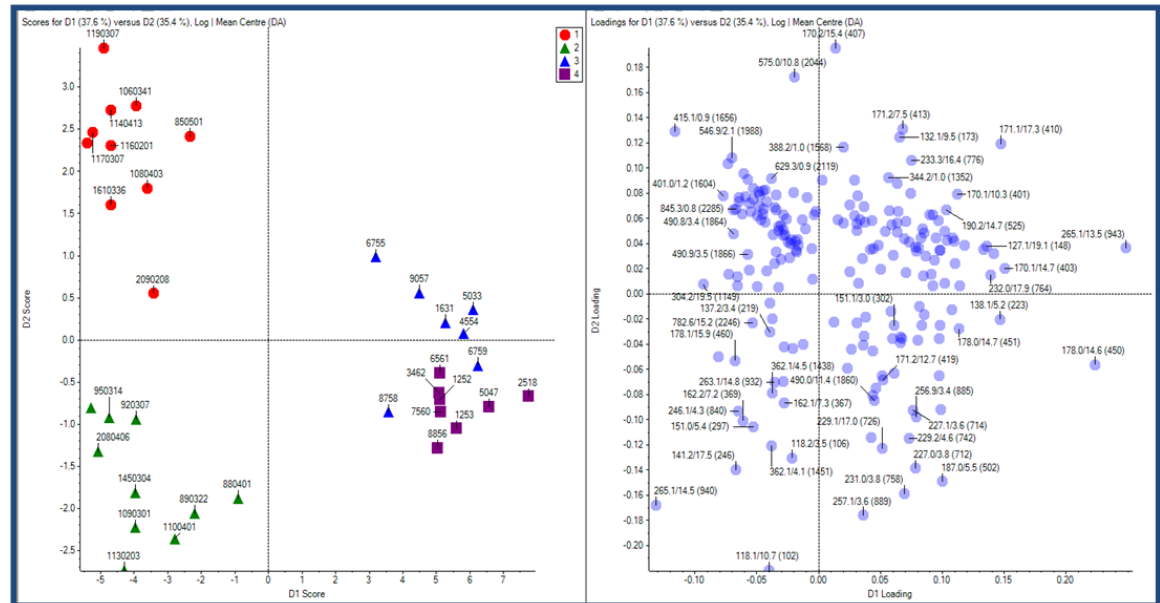
Figure 11. PCA-DA plot of the PKD HILIC-LC–ESI–MS after manual feature selection. Groups were color-coded as: 1-red: female PKD, 2-green: male PKD, 3- blue: female control, 4-purple: male control. Total 35 samples, 206